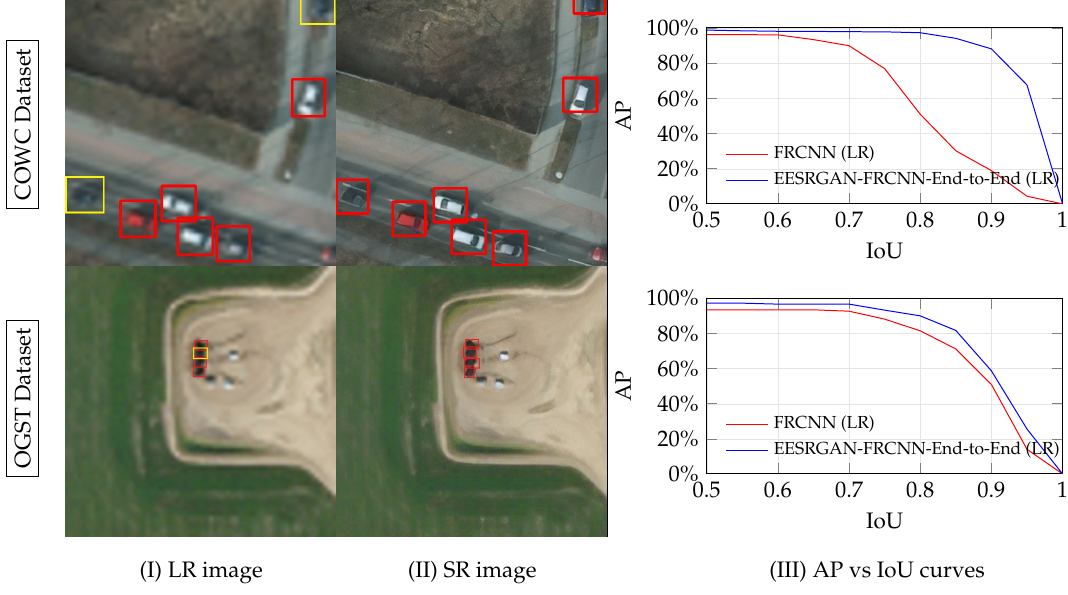
Figure 1. Detection on LR (low-resolution) images (60 cm/pixel) is shown in (I); in (II), we show the detection on generated SR (super-resolution) images (15 cm/pixel). The first row of this figure represents the COWC (car overhead with context) dataset [31], and the second row represents the OGST (oil and gas storage tank) dataset [32]. AP (average precision) values versus different IoU (intersection over union) values for the LR test set and generated SR images from the LR images are shown in (III) for both the datasets. We use FRCNN (faster region-based CNN) detector on LR images for detection. Then instead of using LR images directly, we use our proposed end-to-end EESRGAN (edge-enhanced SRGAN) and FRCNN architecture (EESRGAN-FRCNN) to generate SR images and simultaneously detect objects from the SR images. The red bounding boxes represent true positives, and yellow bounding boxes represent false negatives. IoU = 0.75 is used for